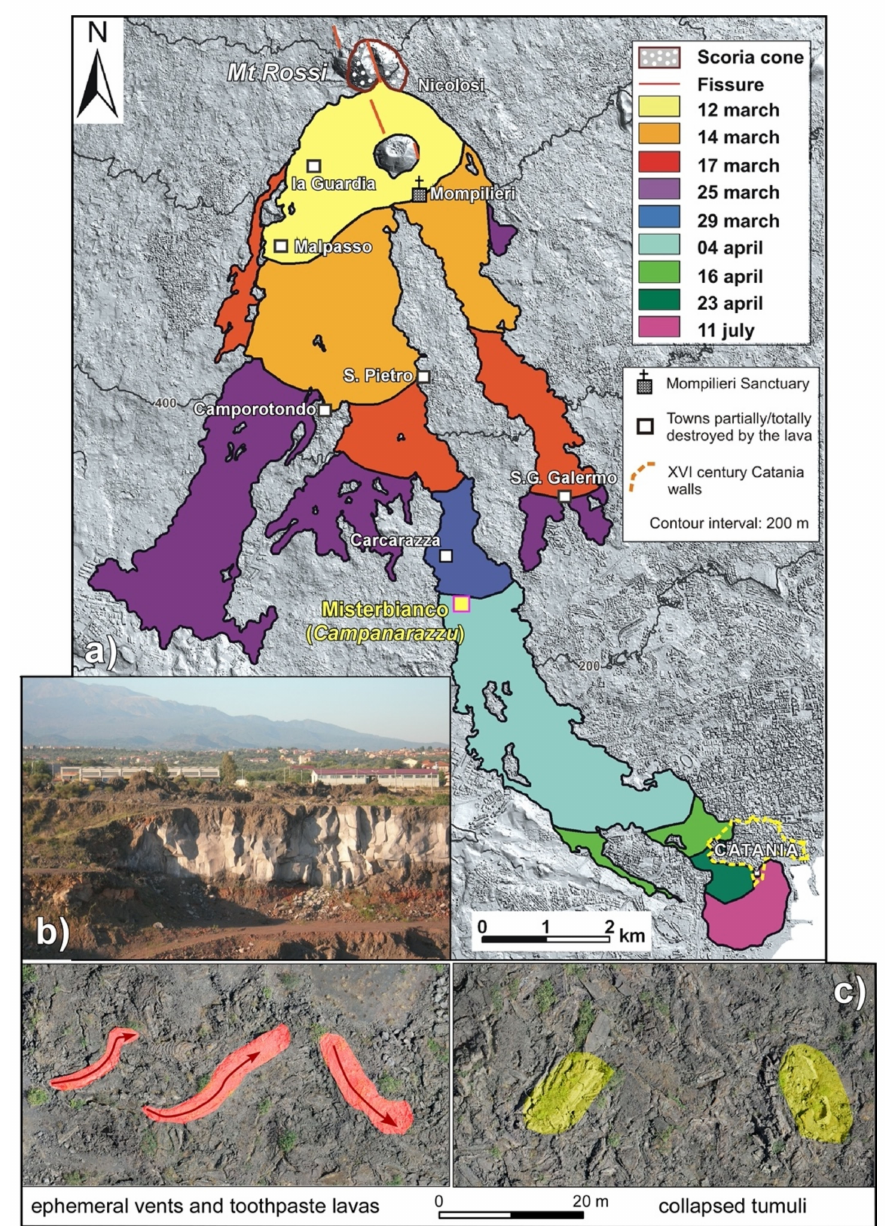
Figure 3. ( a ) Temporal progression of the 1669 lava flow field and location of the main settlements overrun by the lava; ( b ) view of the basalt quarry 300 m north-east of the Mother Church showing the basal flow unit, 14 m thick, of the 1669 lava field, that rests on a thin reddish paleosoil; ( c ) detail of the drone photogrammetry showing the typical features of lava morphology in the investigated